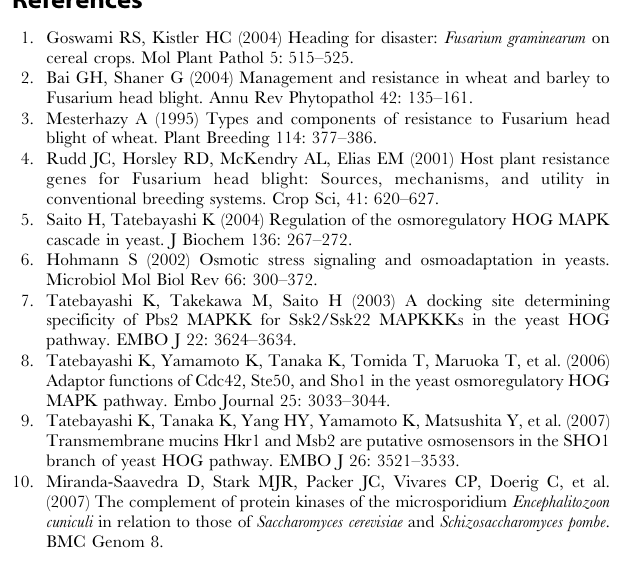
Fig. S1 Growth and colony morphology defects on PDA + 5xYEG plates. Nutritional components of 5xYEG were added to PDA to the final concentrations of regular 5xYEG medium. Colonies formed by the wild type (PH-1), Fghog1 (HG15), Fgpbs2 (PS15), and Fgssk2 (FK13) mutants, and complemented transformant (HGC1) were photographed after incubation for 3 days. Fig. S2 Growth and colony morphology defects of the Fghog1 , Fgpbs2 , and Fgssk2 mutants on PDA plates with 1 mM tert-butyl hydroperoxide (TBOOH). Photographs were taken after incubation at 25 u C for 4 days.